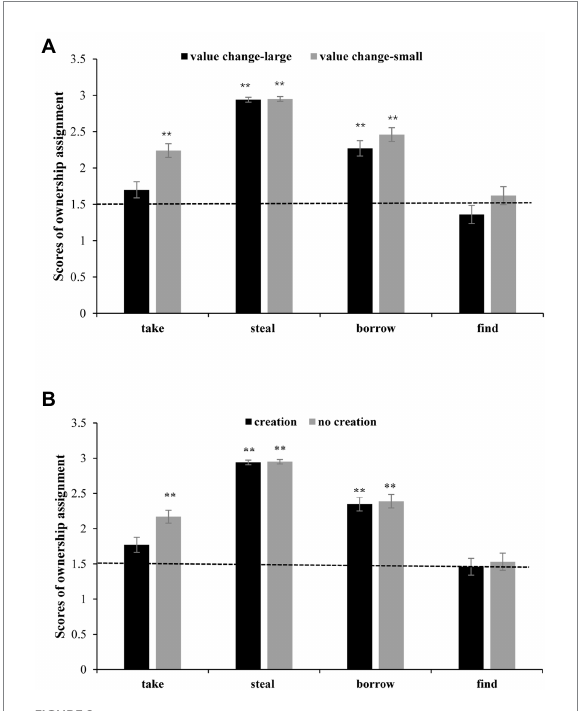
FIGURE 2 Ownership scores in different transfer conditions in Study 2. (A) Transfer type × value change interaction; and (B) transfer type × creation interaction. Note: * p < 0.05, ** p <